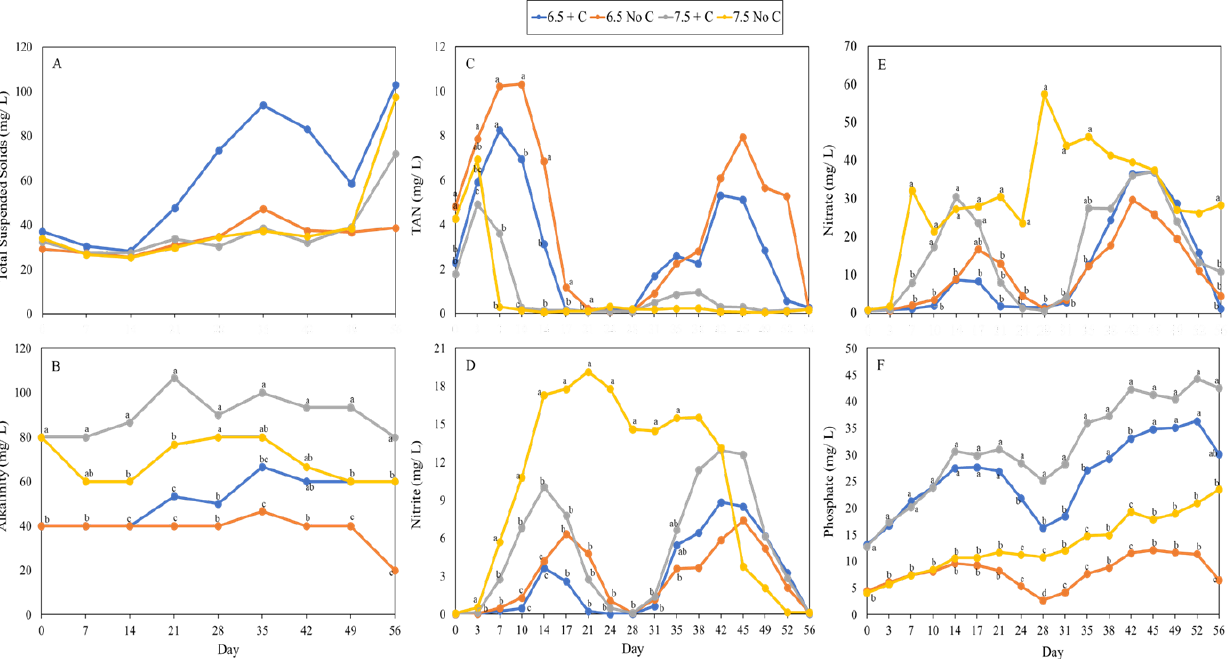
Figure 5. The change of total suspended solids ( A ), alkalinity ( B ), TAN ( C ), nitrite ( D ), nitrate ( E ), and phosphate ( F ) concentrations in marine aquaponics under two pH levels with or without additional C for 8 weeks. Lowercase alphabet letters represent significant differences, followed by one way ANOVA and Tukey’s HSD test ( α =